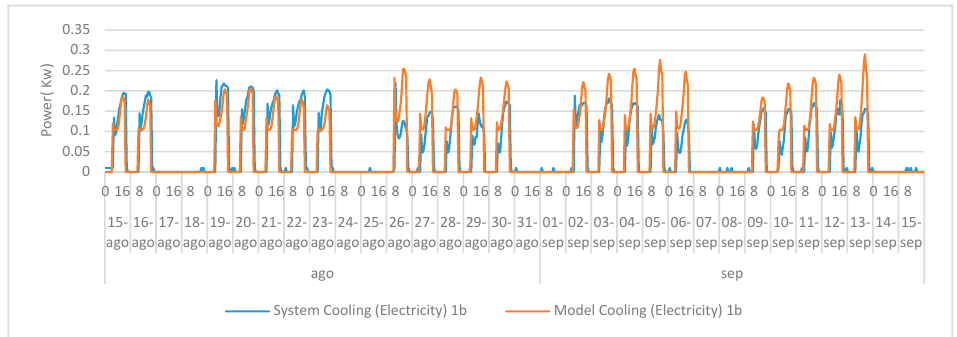
Figure 11. Module 1b. Behavior of the System and model cooling climatic system.